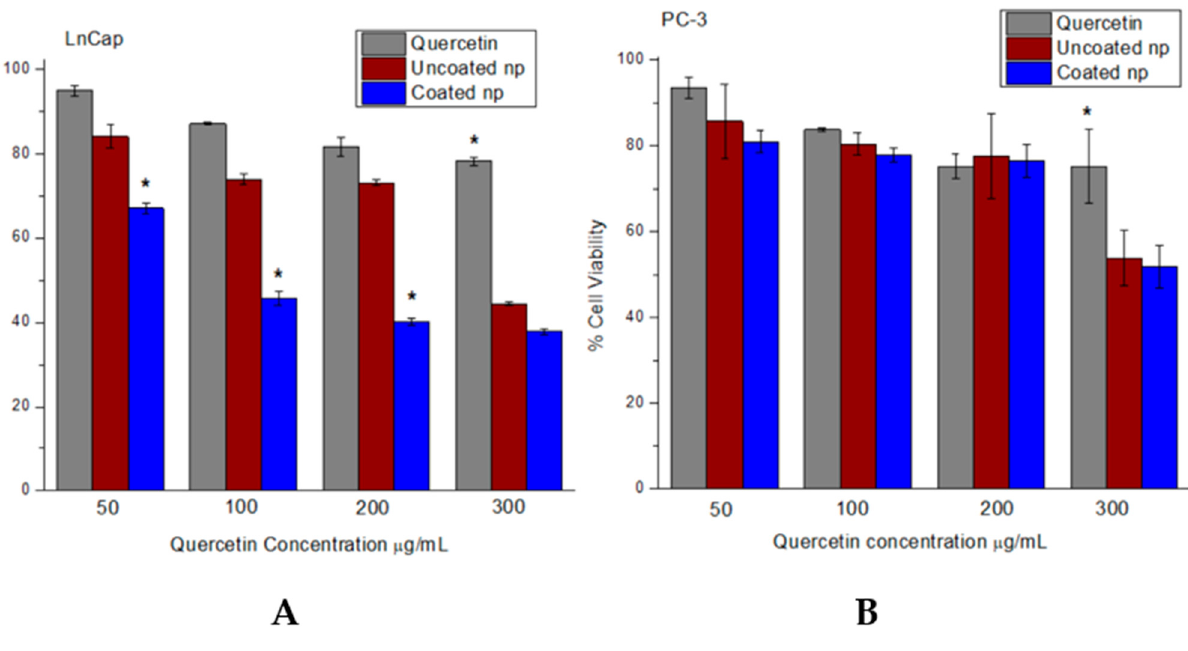
Figure 8. In vitro cell viability of ( A ) LnCap and ( B ) PC-3 cells after being treated for 72 h with free quercetin, uncoated, and coated nanoparticles (* p -value < 0.05).